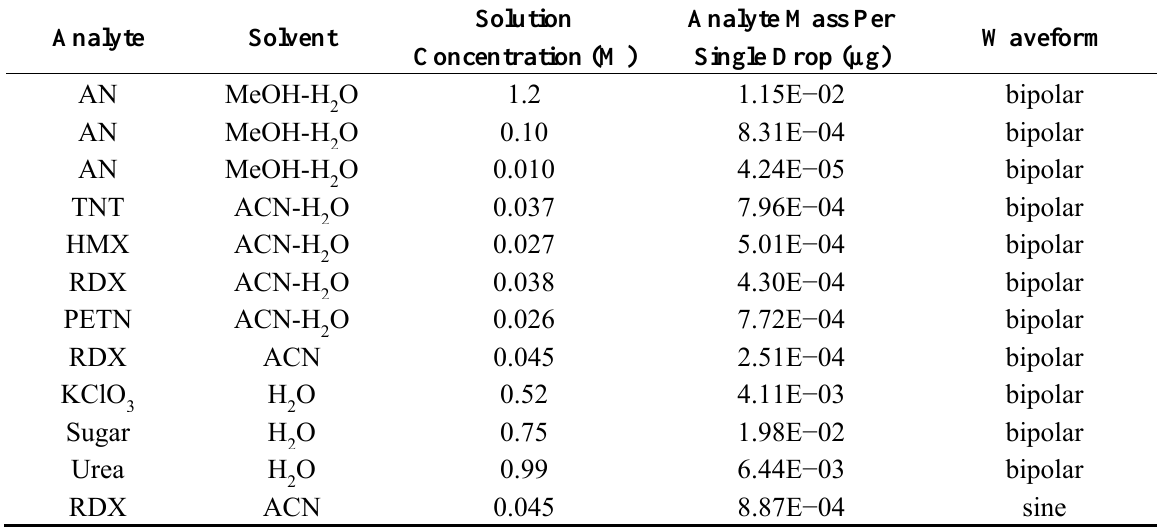
Table 3. Inkjet target analyte solution concentrations and corresponding calibrated droplet